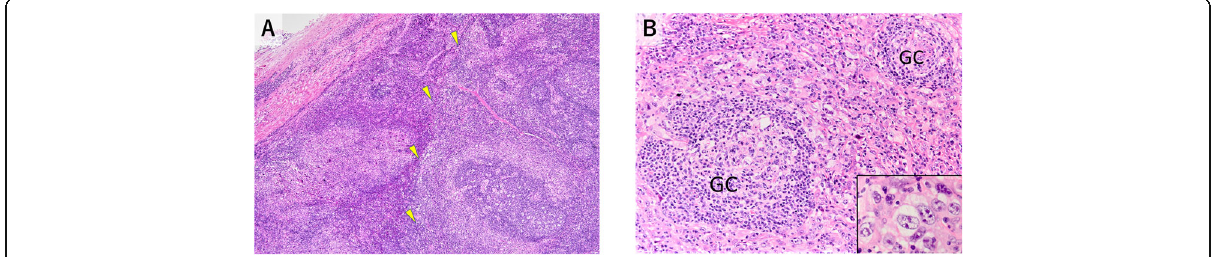
Fig. 2 Histology of the primary cytokeratin-positive interstitial reticulum cell (CIRC) tumor of the biopsied lymph node. a The nodal architecture showed effacement caused by neoplastic proliferation on the left side. Circumferential tumor cell proliferation around follicles was conspicuous on the right side. The tumor margin was vaguely detectable ( arrowheads ). b Proliferating tumor cells around the germinal center ( GC ) were large in size and round or polygonal. Most of them had round vesicular nuclei and prominent nucleoli. The abundant cytoplasm was pale to eosinophilic. Tumor cells were admixed with many small lymphocytes, plasma cells and eosinophils. Inset : high-magnification view of the tumor